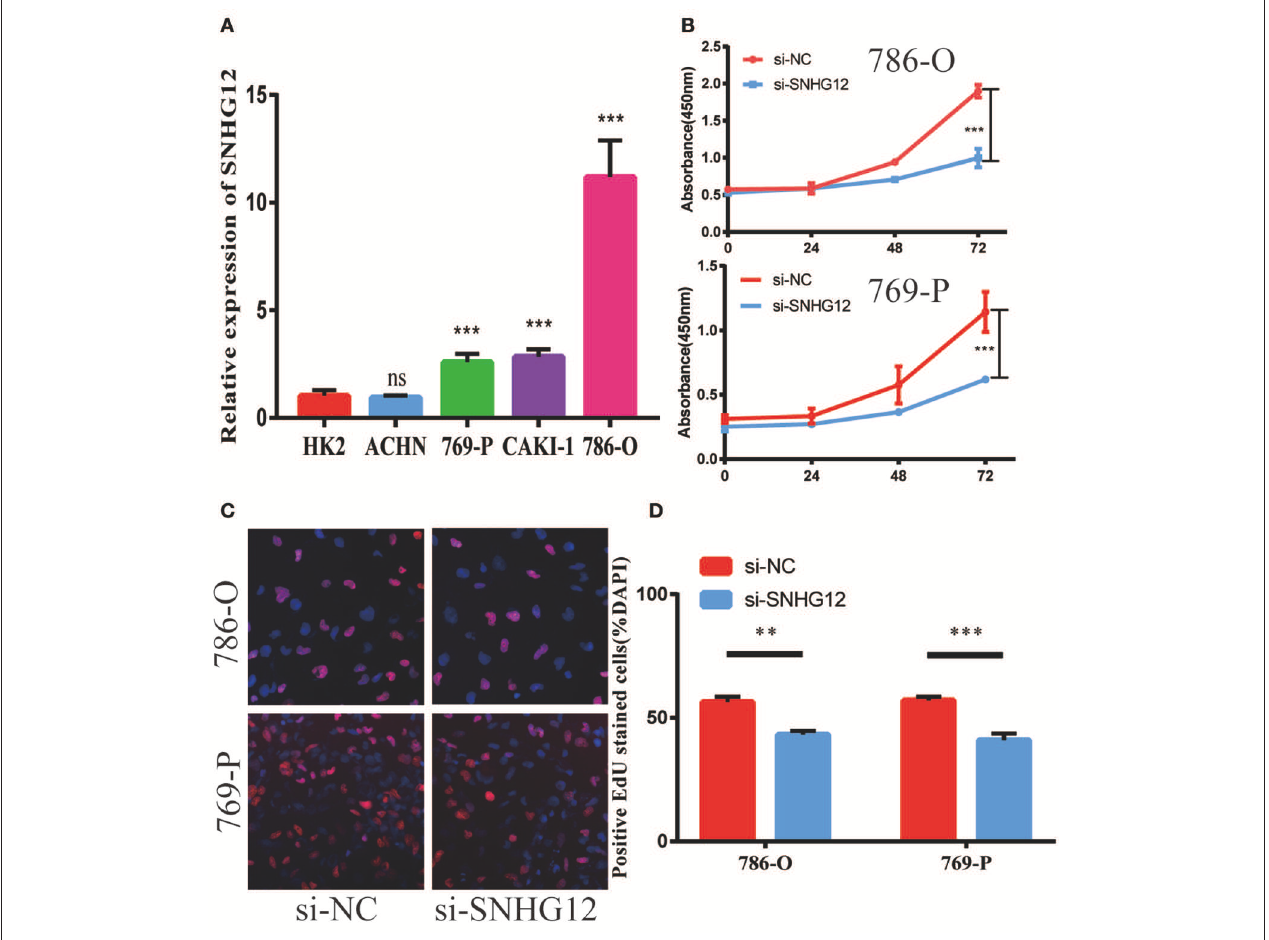
FIGURE 2 | Effects of SNHG12 on ccRCC cells’ proliferation ability. (A) Relative expression of SNHG12 in renal tubular epithelial cells (HK2) and ccRCC cell lines. (B) CCK8 assays were performed to determine the proliferation ability of si-SNHG12-transfected cells. (C,D) Edu staining assays were performed to determine the proliferation ability of si-SNHG12-transfected cells. Error bars stand for the mean ± SD of at least triplicate experiments. ** P < 0.01; *** P <